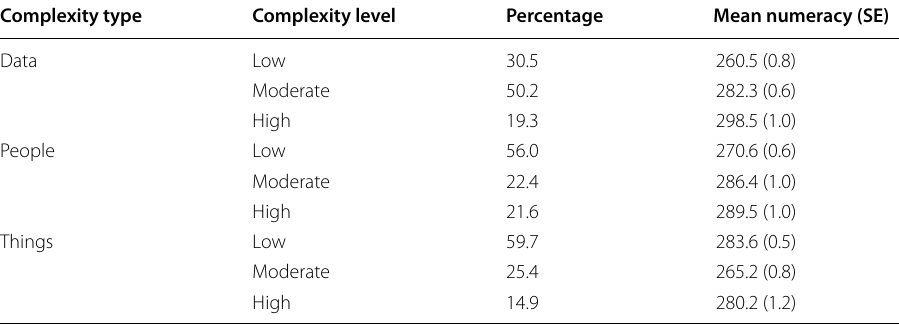
Table 3 Percentages and mean numeracy scores for each occupational complexity level, for each dimension. Source: PIAAC 2012, DOT index, ISCO-08 codes